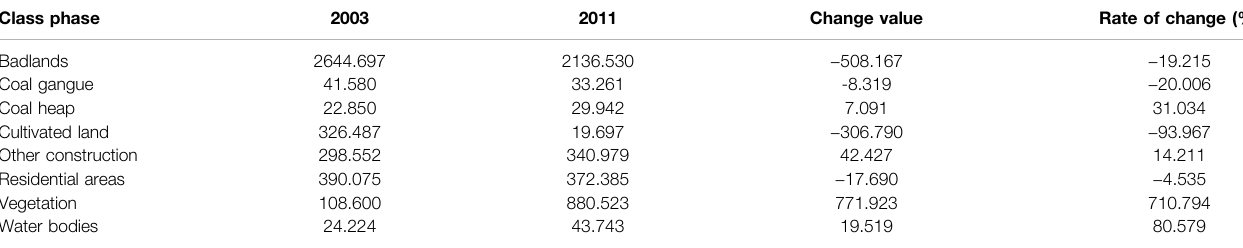
TABLE 6 | Land-use classes changes from 2003 to 2011 (unit: 10 – 2 km 2 ).